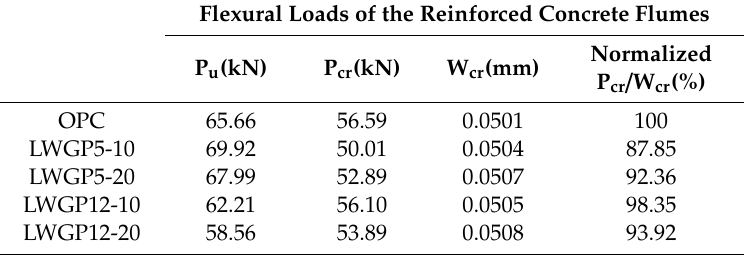
Table 5. Compressive and flexural load results with the crack